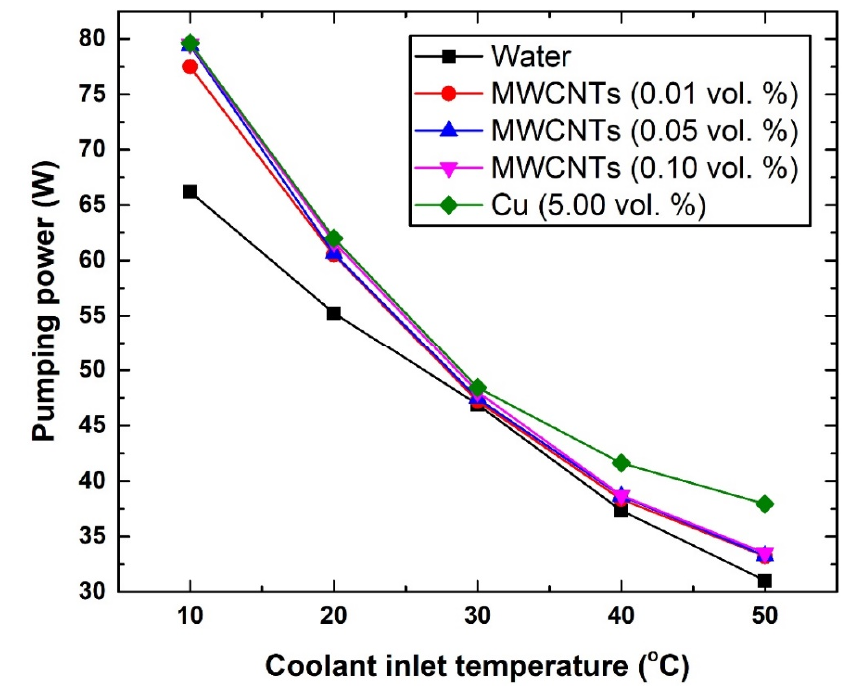
Figure 11. Changes in pumping power with respect to coolant inlet